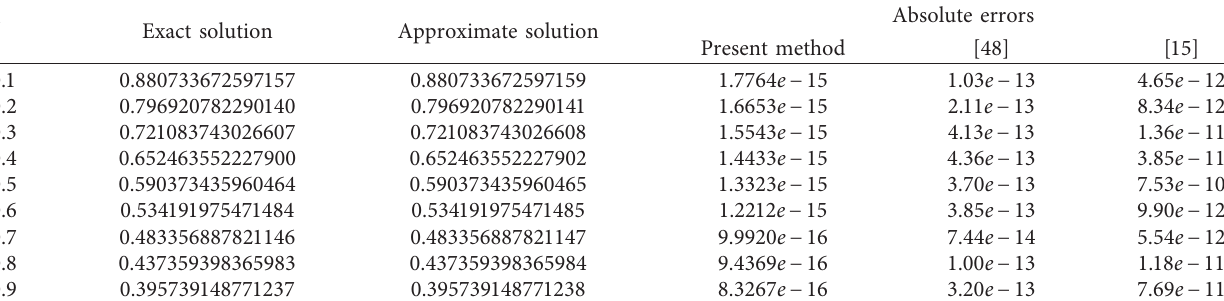
Table 4: Comparison of solutions for various values of ξ for Test Problem 4.3.